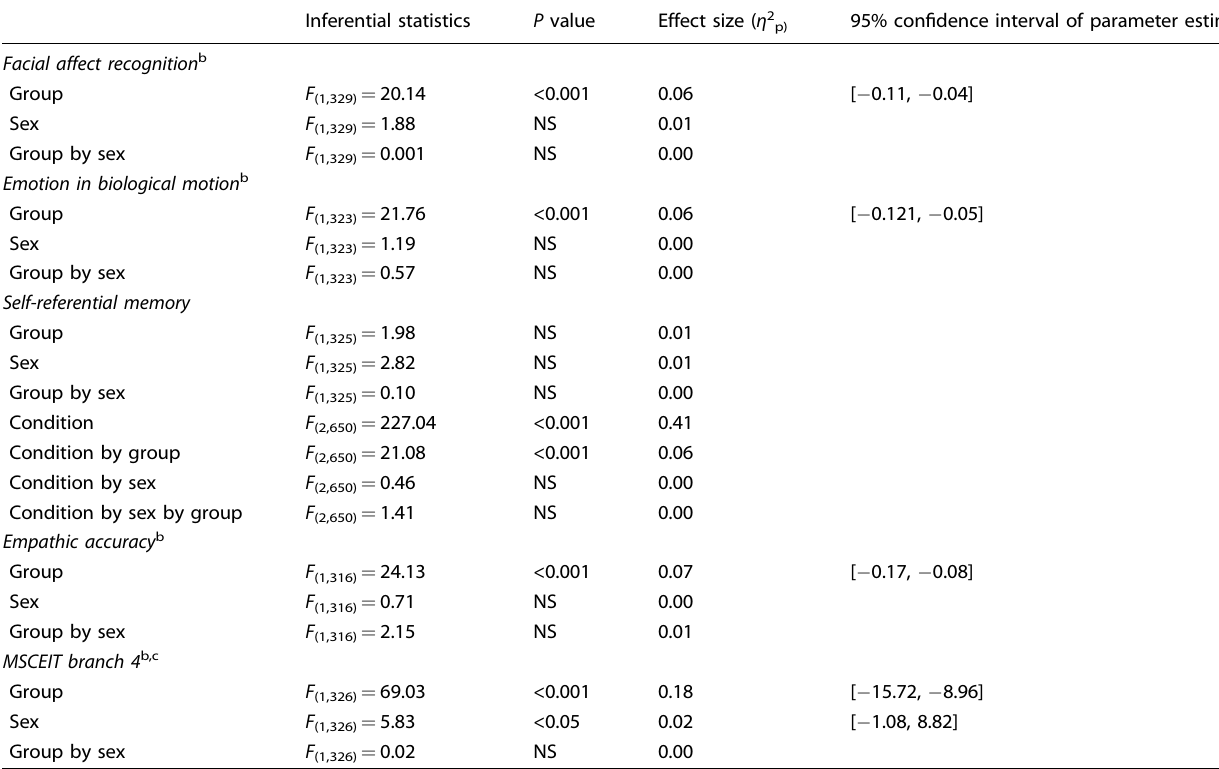
Table 2. Performance on objective social cognitive